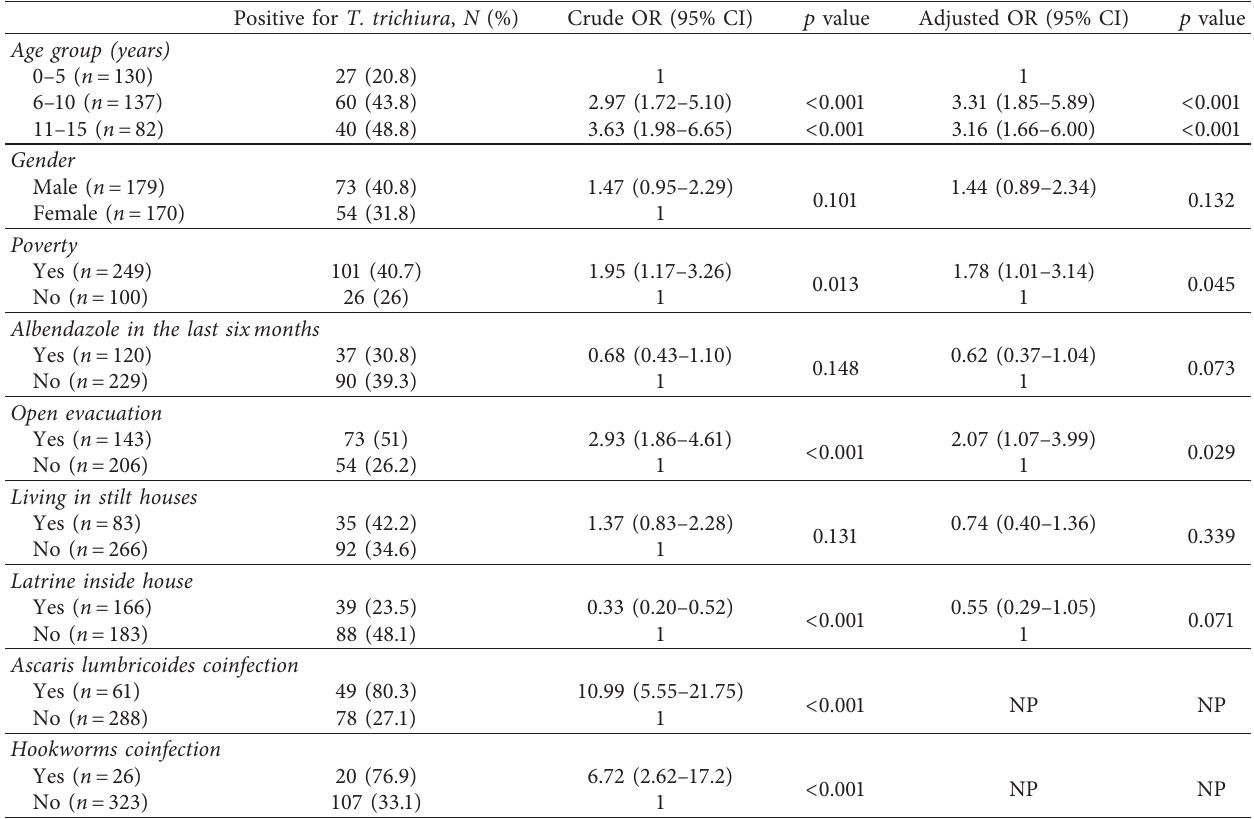
Table 2: Factors associated with trichuriasis in children living in the urban area of Bagre, Par´a State, Brazilian Amazon.